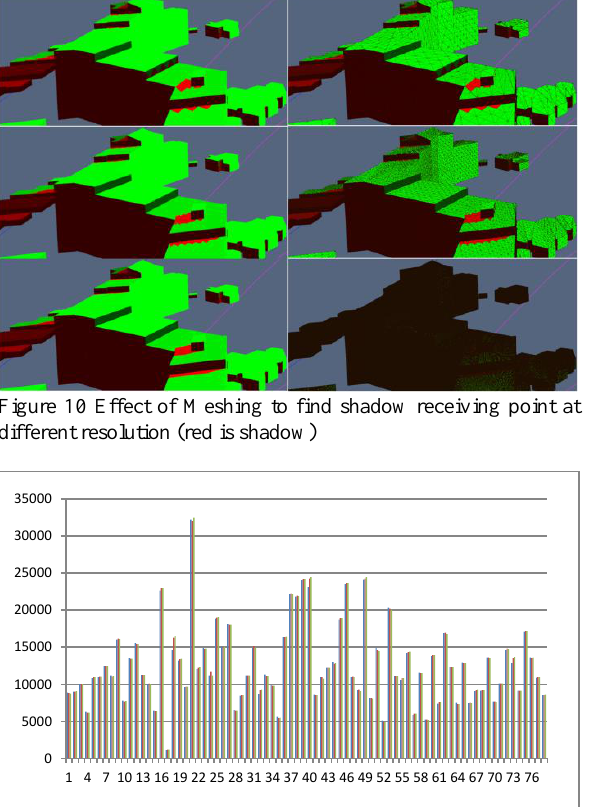
Figure 9 Comparison of hourly and minutely radiation calculation of the shortest day of 2015 (radiation in Wm -2 on the vertical axis) Figure 11 Comparison of a meshing resolution and its effect. (radiation in Wm -2 on the vertical